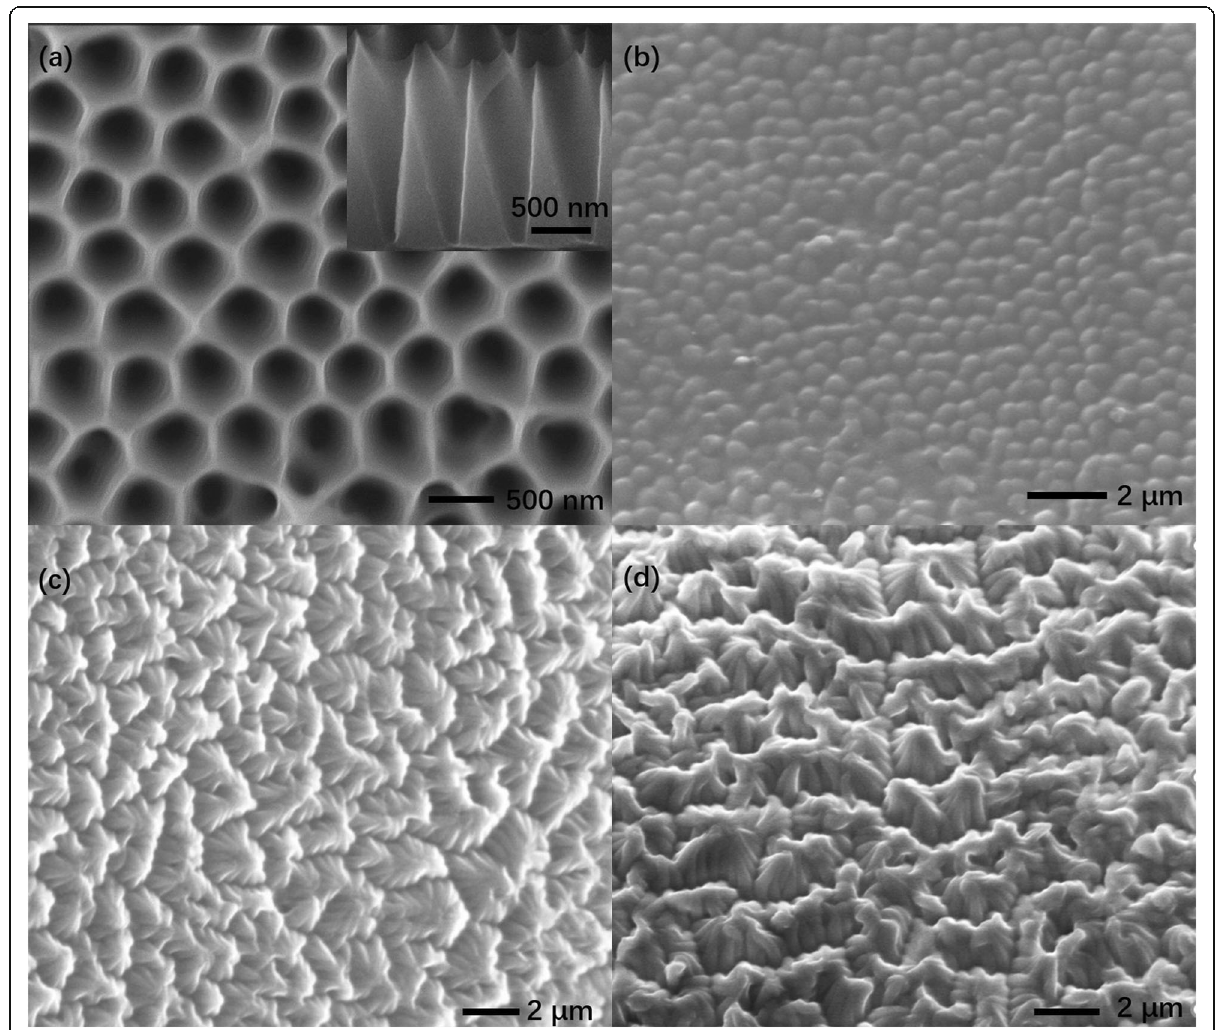
Fig. 2 SEM images of a V-shape AAO template and b – d PDMS nanocones with aspect ratios of 1, 2, and